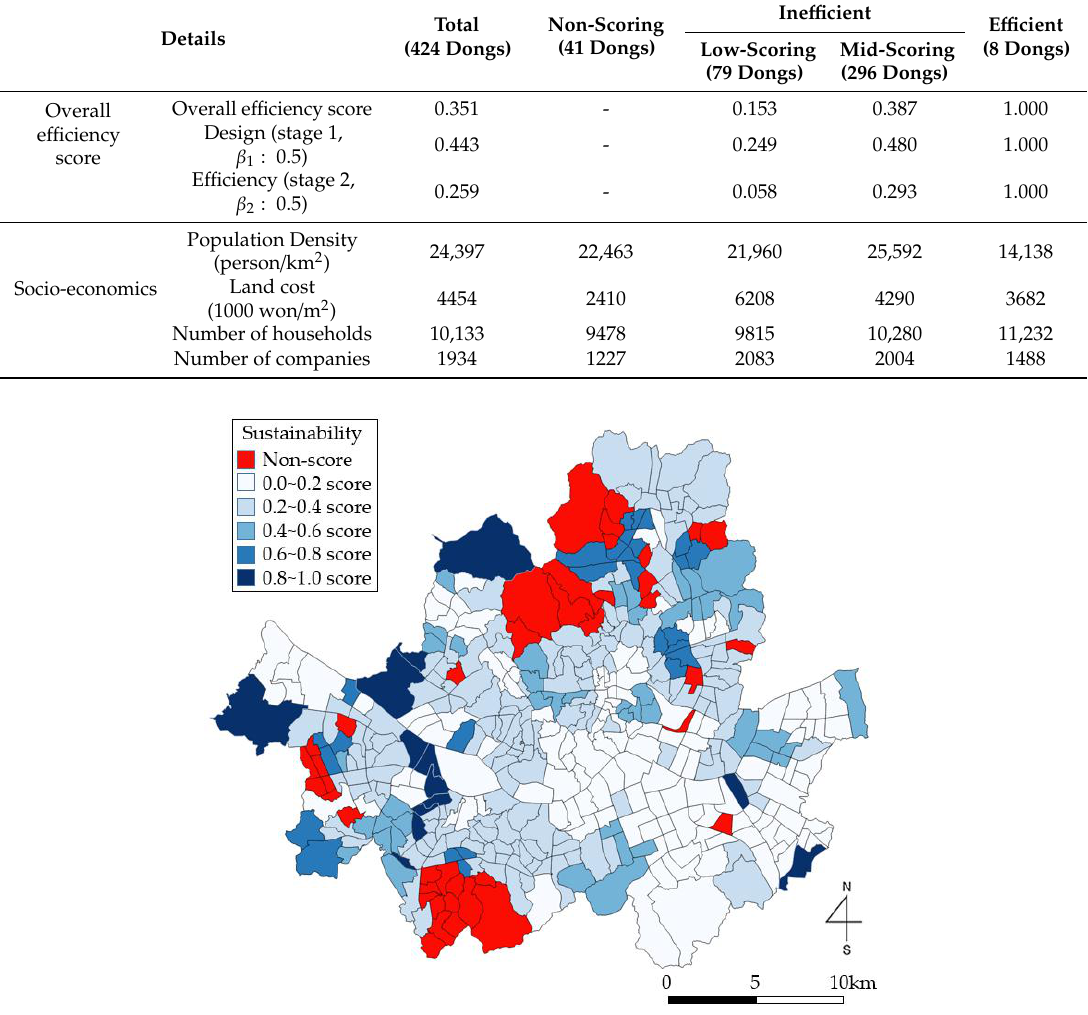
Figure 5. Visualization of the efficiency evaluation results by dong unit in Seoul.